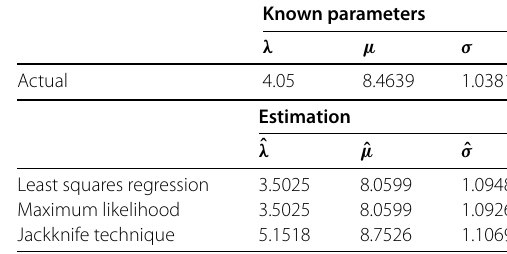
Table 4 Parameter estimation for TS